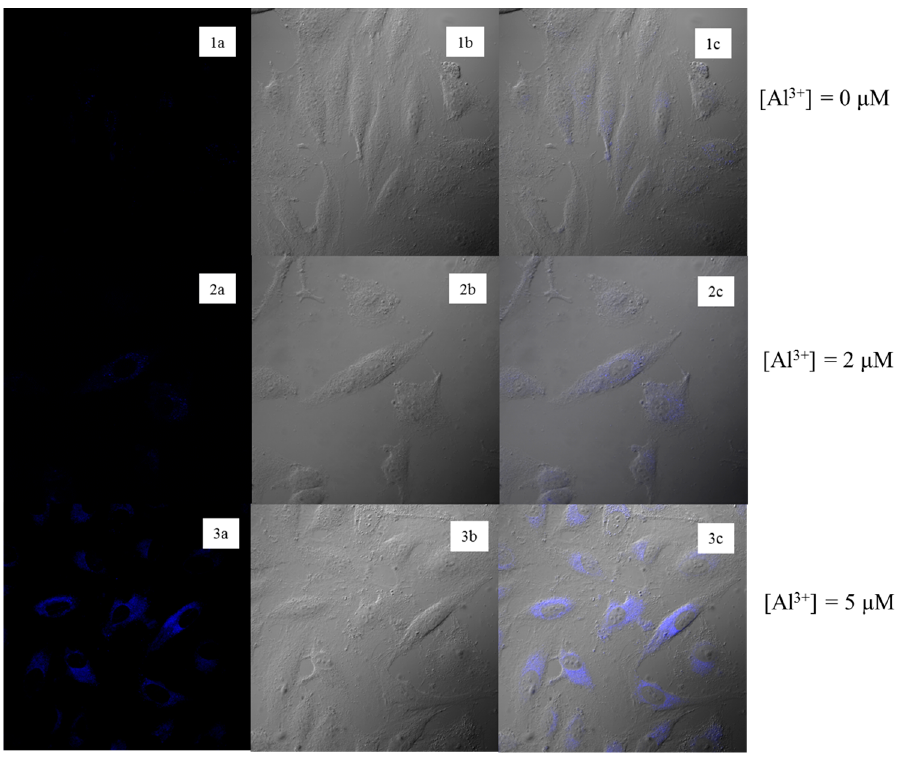
Figure 5. Fluorescence microscope images of ITEC (5 μ M) in living HeLa cells with different concentrations of Al 3+ (0 μ M, 2 μ M, and 5 μ M, respectively).